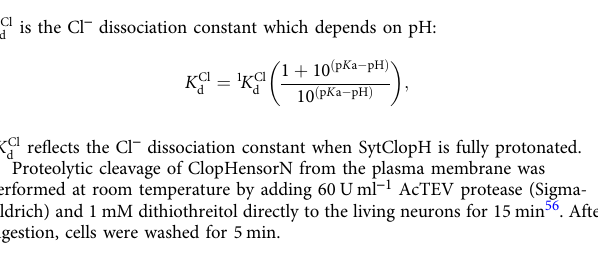
Functional analysis of VGLUT in HEK293T cells . For electrophysiological ana- lysis of VGLUT anion currents in mammalian cells, we subcloned rat VGLUT1 cDNAs (kindly provided by Dr. Shigeo Takamori) into pcDNA3.1 and mutated the dileucine-like endocytosis motif to alanine as reported by Eriksen et al. 17 . HEK 293 cells passage 3 – 5 (cell line name; tsA201, Cat. No. 96121229, Sigma-Aldrich) were transiently transfected with 2 – 5 μ g of plasmid DNA using a calcium phosphate precipitation method and examined 36 h later. In brief, DNA was mixed with 330 µ l of buffered water (2.5 mM HEPES) and 56.5 µ l of 2.5M CaCl 2 by pipetting, subsequently 570 µ l of 2× HeBS buffer (280nM NaCl, 50mM HEPES, 1.5mM Na 2 PO 4 , adjusted with 2M NaOH to pH 7.00) was added dropwise under agitation by vortexing. The DNA-Calcium precipitate was leaved at room temperature for 5 min and thereafter was added to the HEK 293 cells (cultured in a 5 cm dish with 70 – 80% con fl uence). Standard whole-cell patch clamp recordings were performed using an EPC-10 ampli fi er, controlled by PatchMaster (HEKA, Germany) 58 . Borosilicate pipettes (Harvard Apparatus, USA) were pulled with resistances of 0.9 – 2 M Ω . Series resistance compensation and capacitance cancellation were applied, resulting in < 5 mV voltage error. The standard external solutions contained (in mM) 145 Choline Cl, 50 MES (2-( N -morpholino)ethanesulfonate) 2 Mg-Gluconate, pH 5.0, with and without RB (10 nM). Cells were dialysed with an internal solution containing 10 NaCl, 30 HEPES, 100 TMA Gluconate, 2 MgCl 2 , 5 EGTA; pH 7.4, and held at − 85 mV to established a physiologically low cytoplasmic [Cl − ]. The junction potential was calculated and corrected. Imaging vesicular Cl − in living neurons . For vesicular Cl − imaging SytClopH was used as a ratiometric indicator by excitation. Imaging was performed at room temperature on an inverted microscope (Axiovert 100TV, Zeiss) equipped with a ×63, 1.2 NA water-immersion objective. Images were acquired with a sCMOS camera (Neo 5.5, Andor) controlled by Andor IQ software (Andor) in 2× 2 bin- ning mode. SytClopH was excited sequentially at 458, 488 and 565nm with a computer controlled monochromator (Polychrom V, Till Photonics). Emission was collected with a 525/50 nm Brightline single-band bandpass emission fi lter when